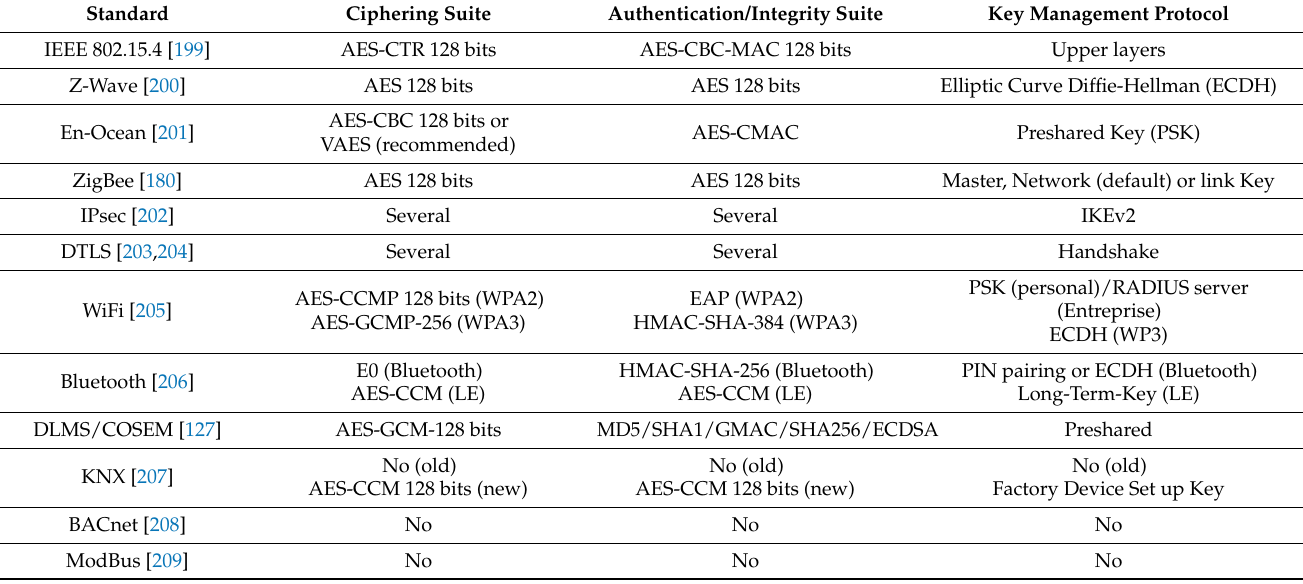
Table 4. Security mechanisms in SG